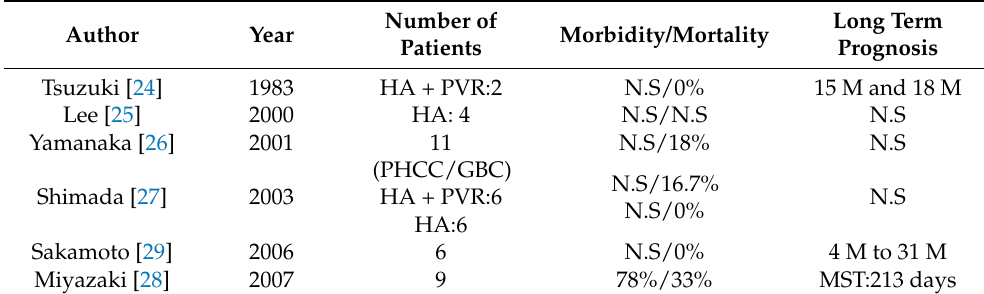
Table 1. Cases of concomitant hepatic artery resection for perihilar cholangiocarcinoma reported in the English literature before